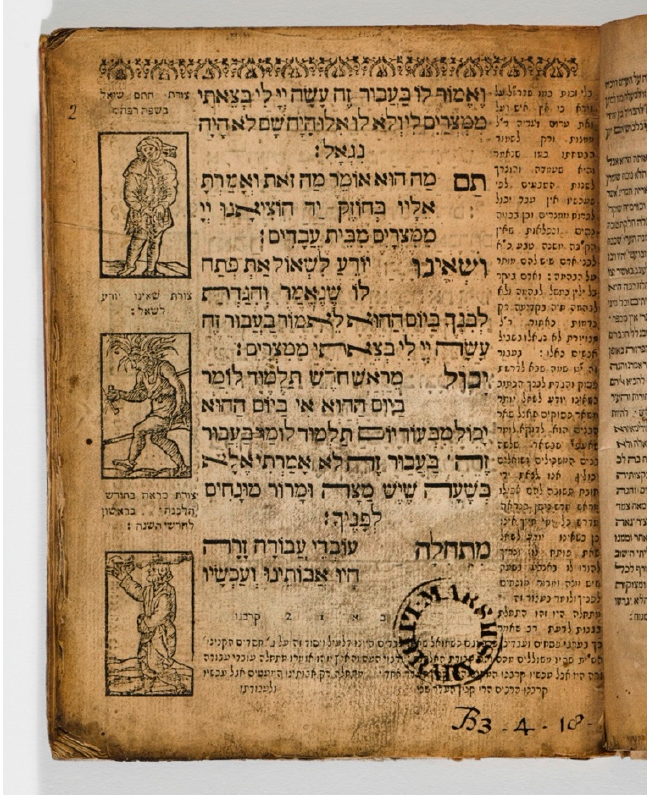
Figure 28. Illustrations from Haggadah; Marsh’s Library B.3.4.18.